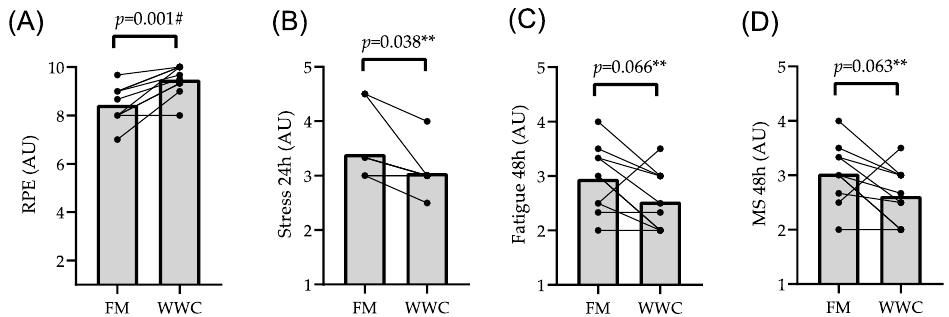
Figure 5. Bar chart with significant differences between periods. FM friendly match; WWC Women world cup; ( A ) RPE assessment of perceived exertion; ( B ) Stress; ( C ) Fatigue; ( D ) muscle pain; arbitrary unit AU; ** moderate effect size; # very large effect size.